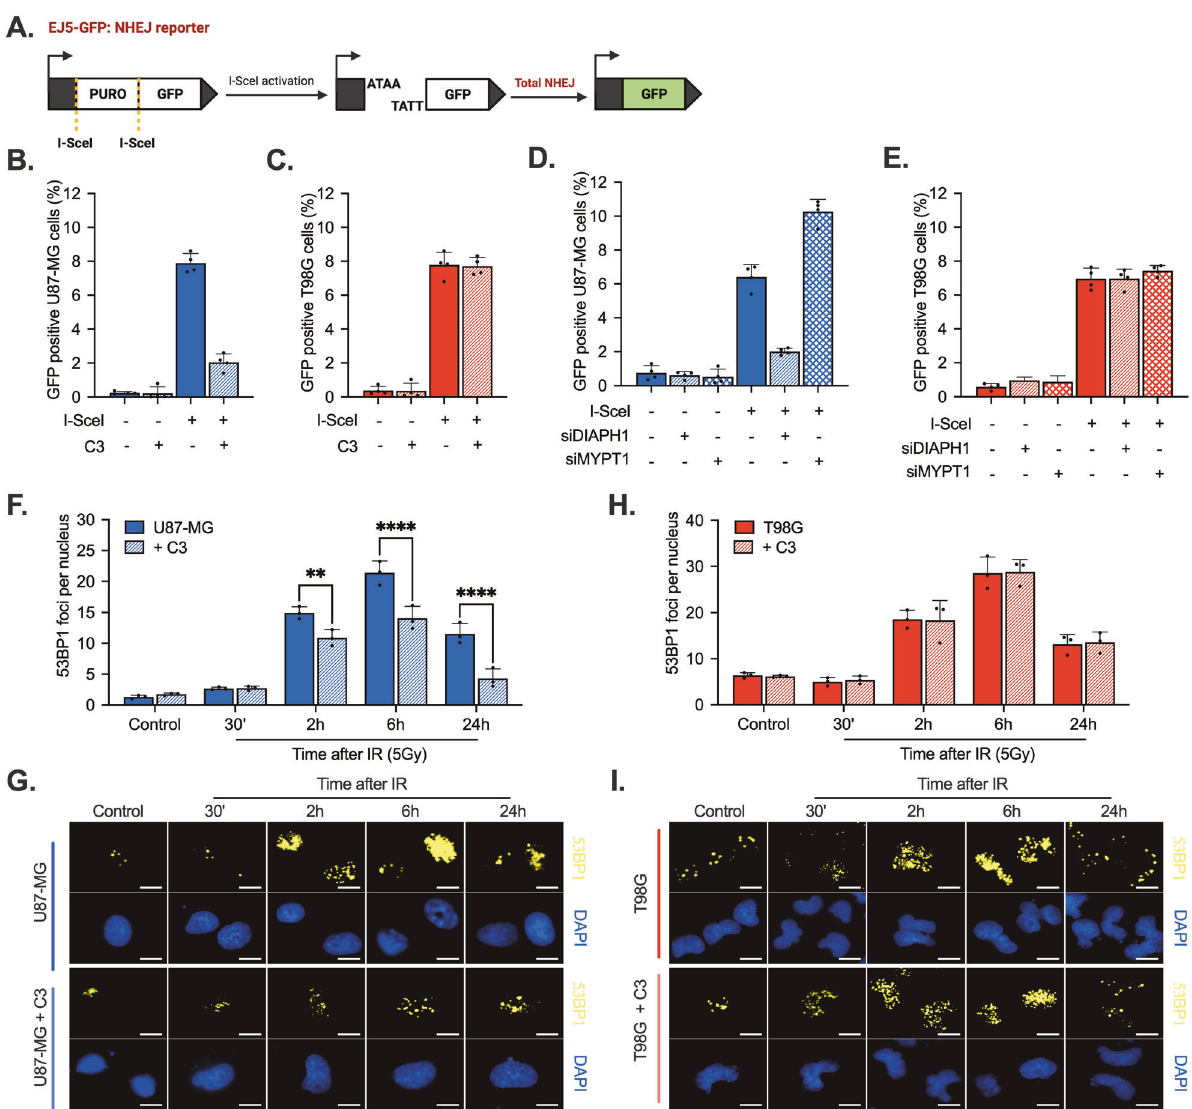
Fig. 4 The nonhomologous end-joining (NHEJ) repair pathway is targeted by Rho inhibition in wild-type p53 cells. A Schematic drawing of the EJ5-GFP vector used for quanti fi cation of DSB repair by NHEJ, created with BioRender.com. The vector contains the GFP gene truncated by a puromycin resistance gene, which is fl anked by two I-SceI restriction sites. I-SceI expression promotes the generation of two breaks in the vector, and if repair occurs by any NHEJ pathway, GFP is expressed, and repair activity can be quanti fi ed by determining the number of GFP- positive cells. B , C NHEJ assays show that Rho inhibition by C3 toxin treatment strongly decreases repair in U87-MG cells ( B ) but not in T98G cells ( C ). Similarly, DIAPH1 knockdown ( D ) also decreases the NHEJ repair capacity, while MYPT1 knockdown enhances the NHEJ repair capacity ( E ). F – I 53BP1 foci formation in response to IR stress was analyzed in U87-MG ( F , G ) and T98G ( H , I ) cells with Rho inhibition induced by C3 toxin treatment. The kinetics of 53BP1 recruitment to DNA damage sites are slowed by Rho inhibition only in wild-type p53 cells ( F , H quanti fi cation of foci per nucleus; G , I representative immuno fl uorescence panel). Immuno fl uorescence images were acquired with a 63x objective; the scale bars indicate 10 µM. The graphs show the mean ± SD of three or four independent experiments, with the averages of individual replicate dots from the GFP signal of 2000 cells, as analyzed by one-way ANOVA in NHEJ assays, or the number of foci in 100 individual nuclei, as analyzed by two-way ANOVA with Sidak ’ s multiple comparison test in the 53BP1 foci assay. Cell Death and Disease (2023)